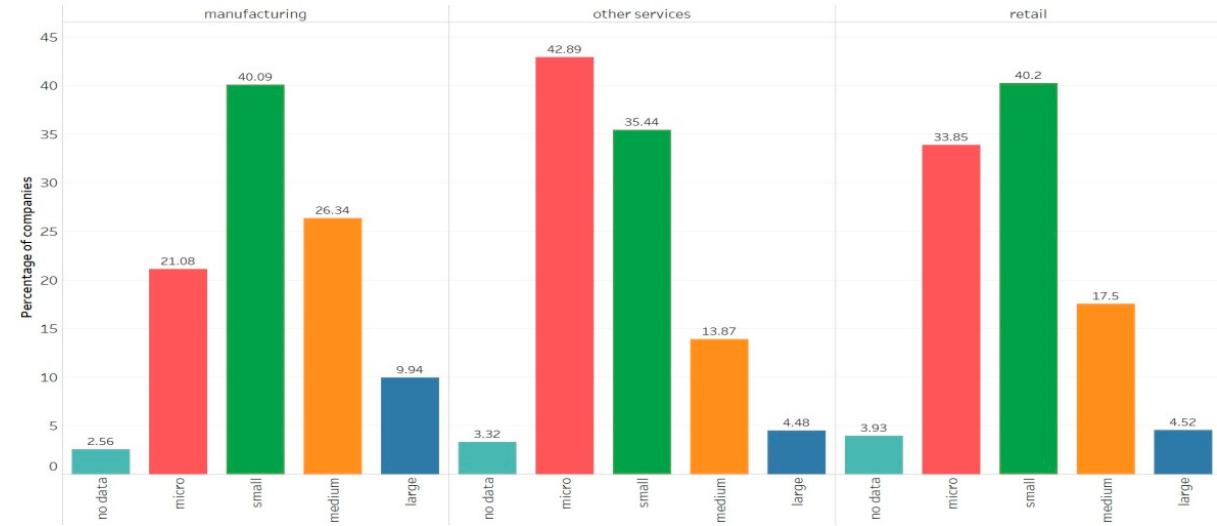
Figure 2. The sample in the term of firm size.